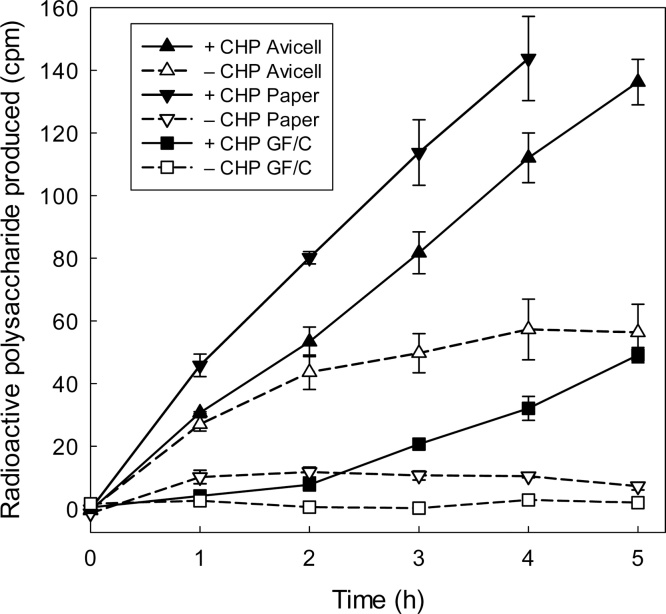
CHP ‘activates’ XTH24 previously bound to cellulose or glass-fibre. Cellulose (Avicel or Whatman No. 3 chromatography paper) or glass-fibre (Whatman GF/C) [20 mg] was incubated together with 150 μl of dilute XTH24 (protein 2.16 μg/ml) for 2 h in polylysine-blocked glass tubes. The enzyme solution was then rinsed out with a large volume of water, and 150 μl of standard XET reaction-mixture, either alone or supplemented with CHP (1.5 mg/ml), was added to the cellulose or glass-fibre. At intervals, 20 μl was removed and assayed for [3H]polysaccharide. In this experiment, a yield of 100 cpm of 3H-polysaccharide indicates 7.4 pmol XXXGol incorporated.